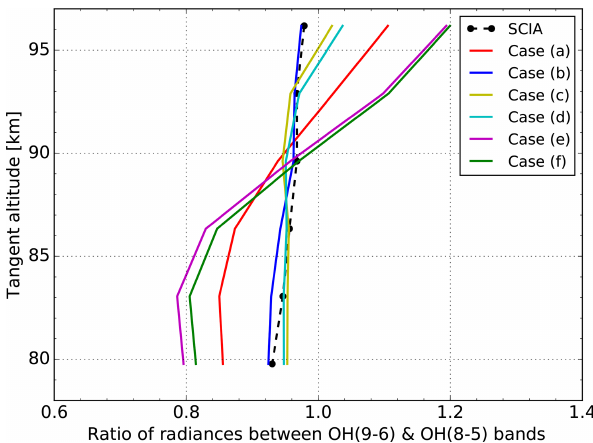
Figure A1. The ratio of the integrated limb radiances between the OH(9–6) (1378–1404nm) and OH(8–5) (1297–1326nm) bands versus tangent altitude. The raw data (black dashed line) are taken from the SCIAMACHY channel-6 measurements. The fitted results (solid line) are obtained by applying the rate coefficients with re- spect to different